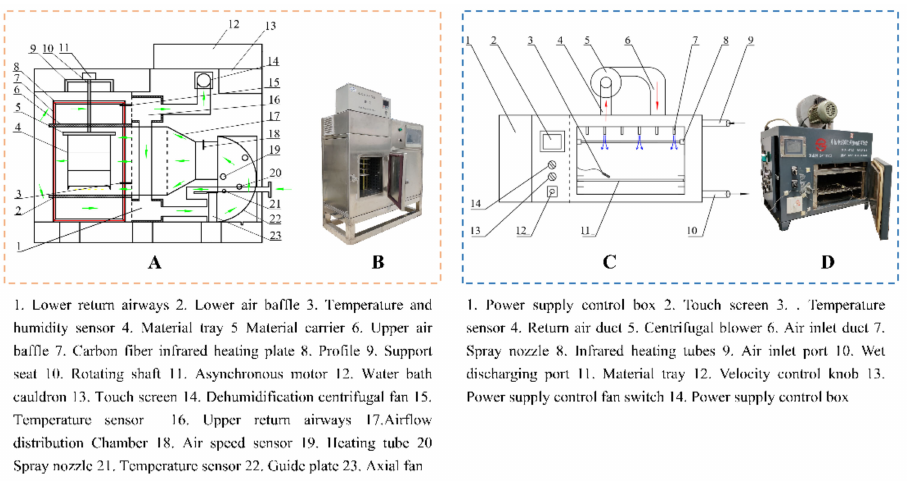
Figure 1. The schematic and physical diagram of dryers (The arrows represent the direction of the